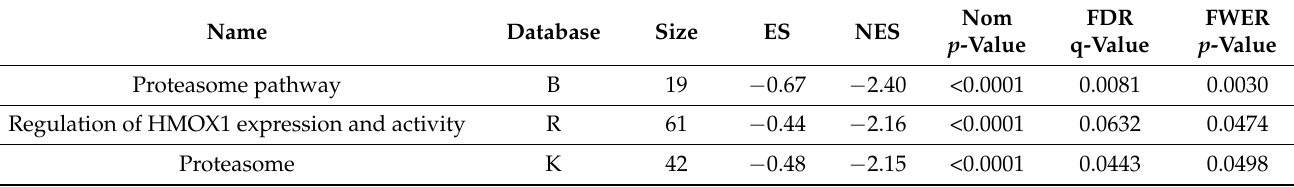
Table 4. Upregulated gene sets in skeletal muscle of patients with T2D analysed with